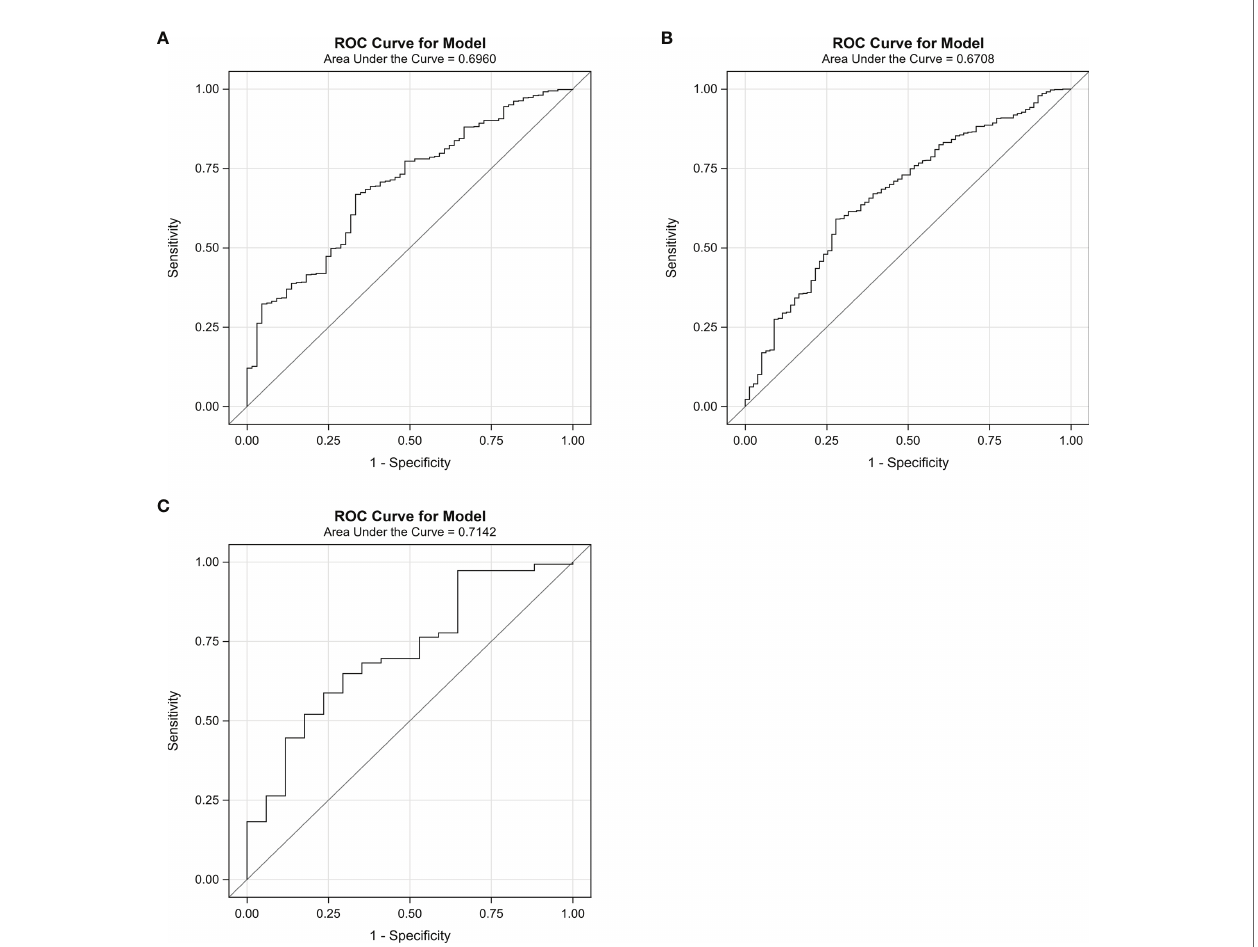
FIGURE 3 | The area under the receiver operating characteristic curve (AUROC) for the algorithm in the training group (A) , the internal validation group (B) , and the external validation dataset (C) . The curve was plotted with sensitivity against 1 − speci fi city. The C-index was 0.70 in the training group, 0.67 in the internal validation group, and 0.71 in the external validation